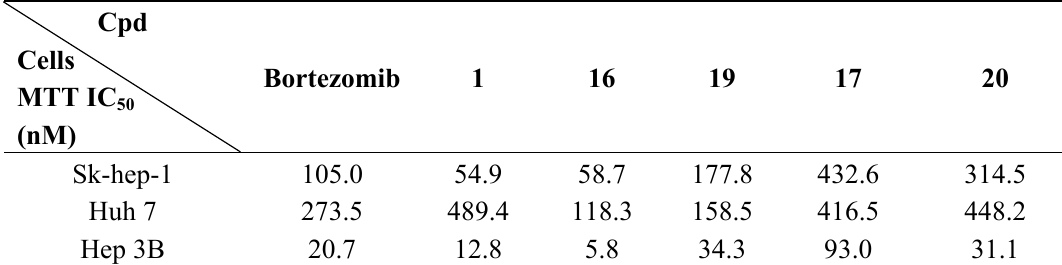
Table 4. IC of growth inhibition in Sk-hep-1, Huh-7, and Hep3B cells with bortezomib, 1 , 50 16 , 17 , 19 , and 20